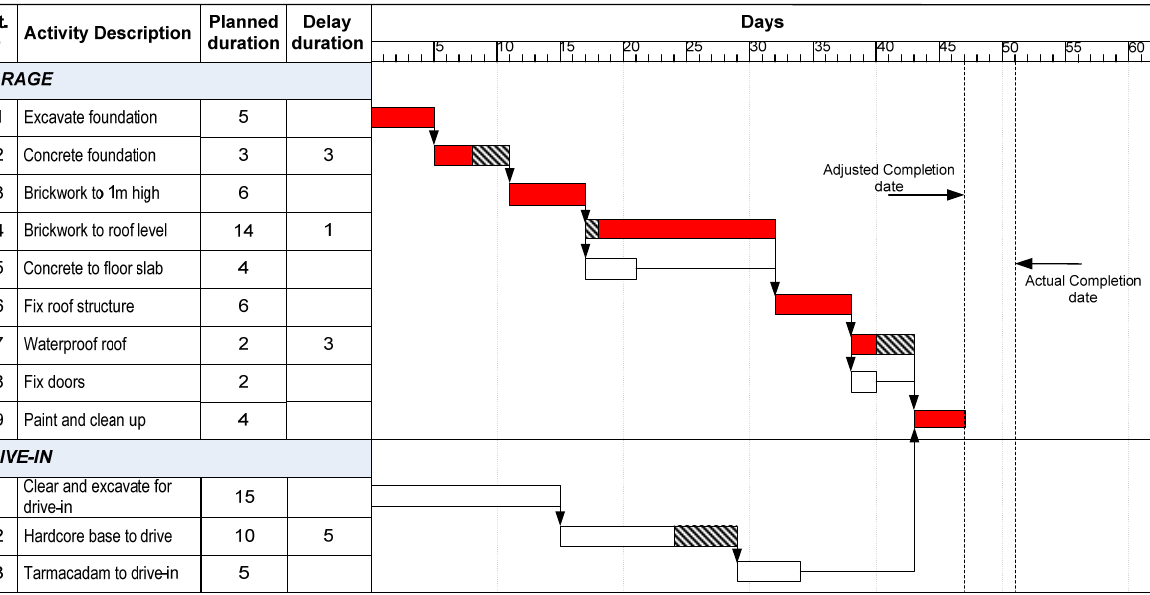
Figure 14. As-planned schedule impacted with contractor’s